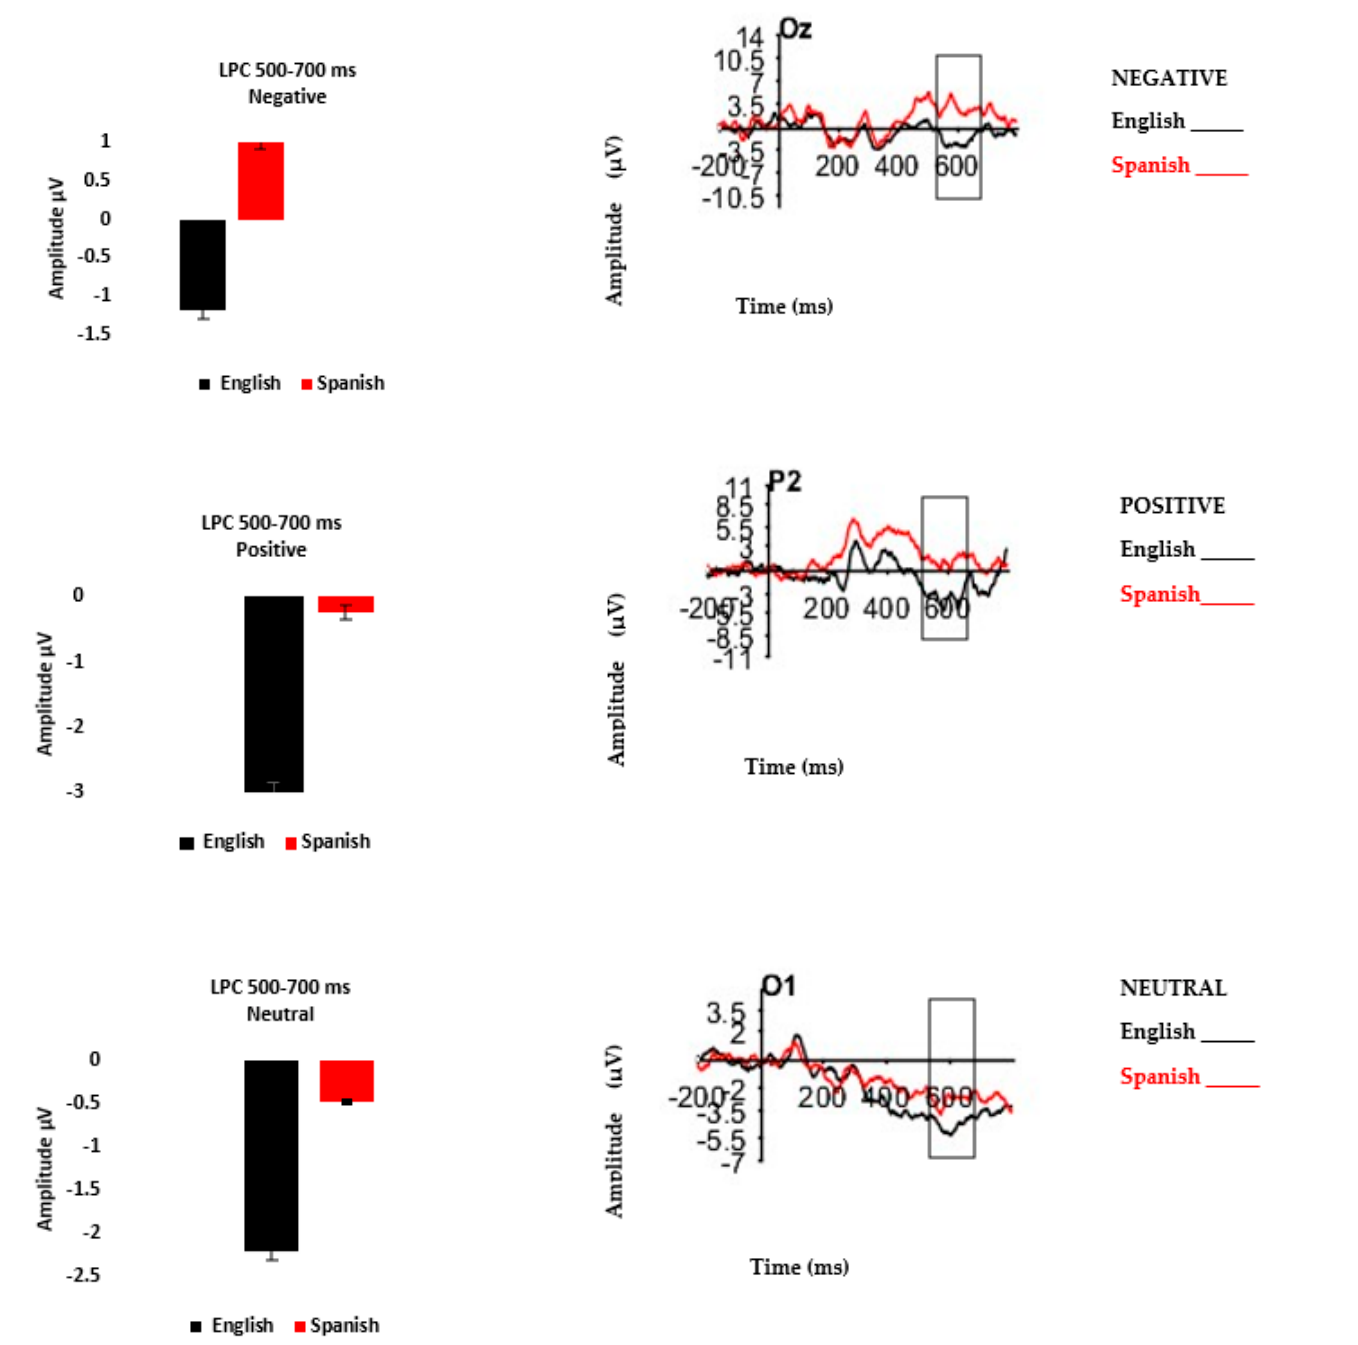
Figure 4. Amplitudes recorded for LPC 500–700 ms as a function of language of the target stimulus. Representative electrodes Oz, P2, and O1 illustrate differences in the LPC responses between English and Spanish negative, positive, and neutral targets. Bar plots show LPC activity averaged across the centro-parietal electrodes and the entire time window for LPC 500–700 ms. Error bars are standard errors.